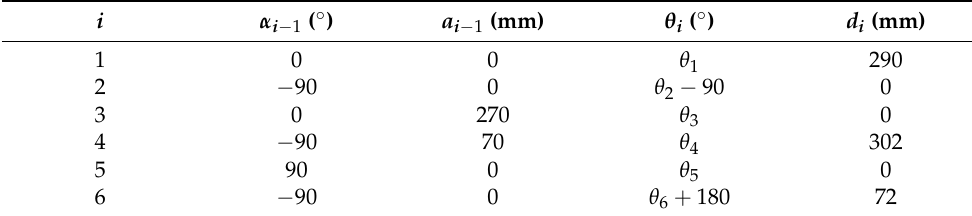
Figure 1. The coordinate system of a 6-joint robot. Table 1. The D-H parameters of a 6-joint robot.